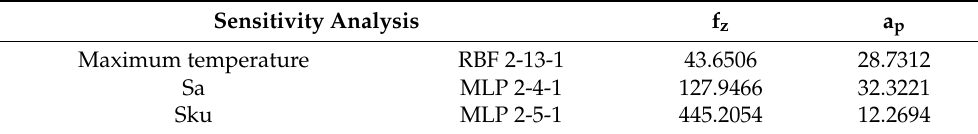
depth of cut a p